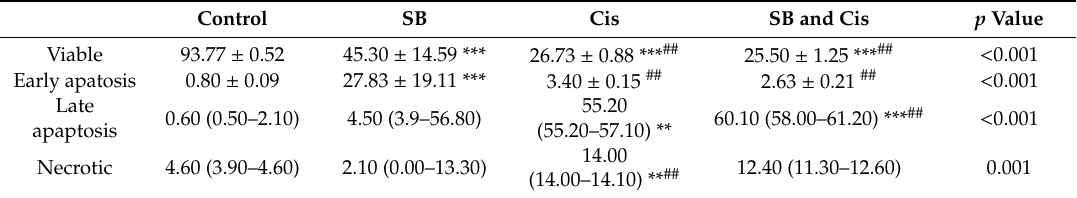
Table 2. Statistical analysis of annexin positive staining detected by flow cytometry in SCC.